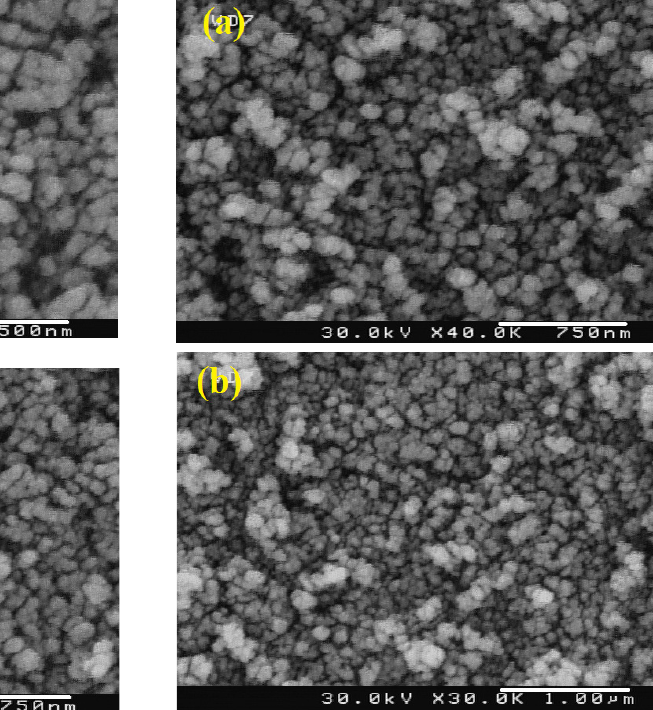
nanoparticles Fig. 4. SEM images of magnetite